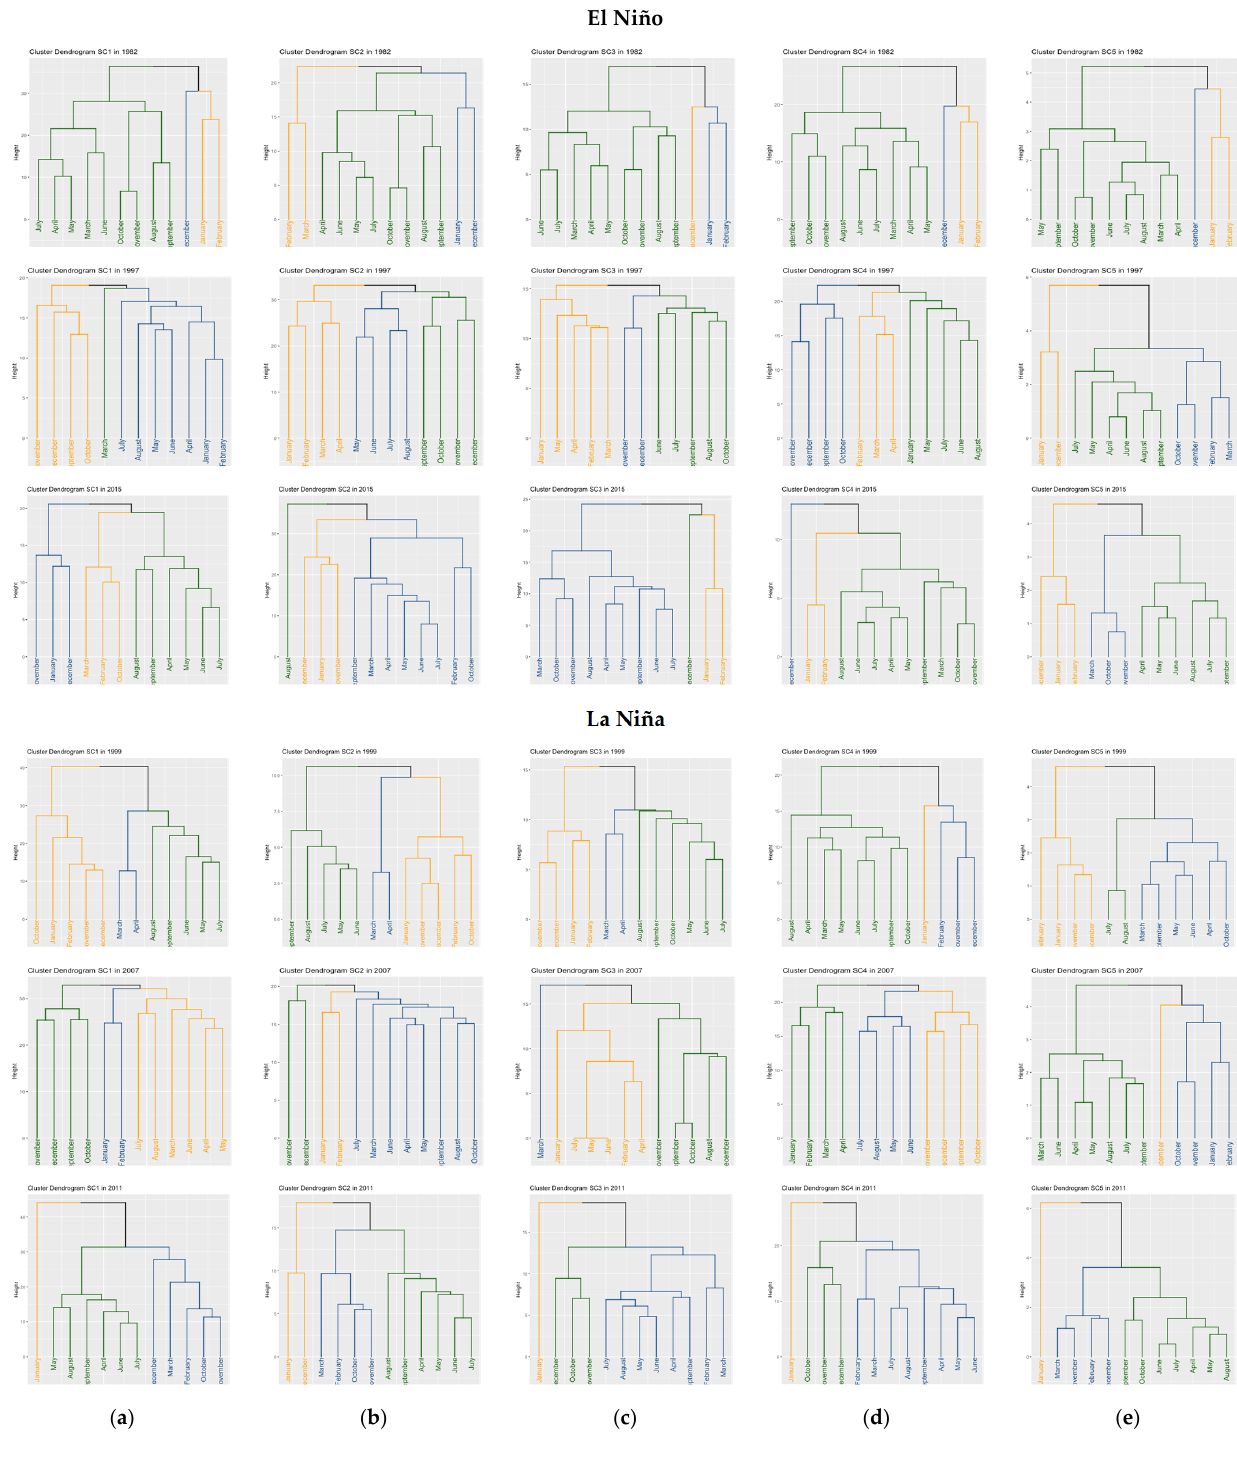
Figure 7. Dendrograms of TGs for the five different SCs discovered by ENSO events, years and SCs: ( a ) SC1; ( b ) SC2; ( c ) SC3; ( d ) SC4; ( e ) SC5. For example, in 1982, TC1 and TC2 in SC1 depicted a very dry season with average precipitation intensity of less than 2 mm/day (Table 5). They were composed of three months. Months of TC1 were December and of TC2 were January and February. TC3, on the other hand, was a slightly wet season with an average precipitation of 2 mm/day or more for 9 months,